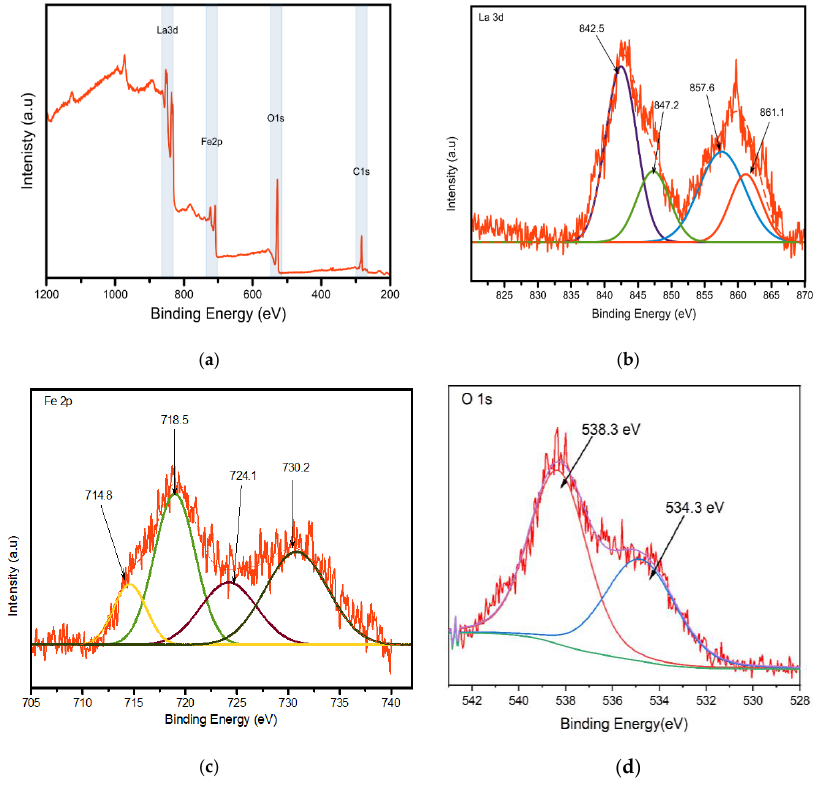
Figure 7. XPS spectra of LaFeO 3 for 1:1 ratio, ( a ) full range survey, ( b ) La3d, ( c ) Fe2P, and ( d ) O1s spectra.